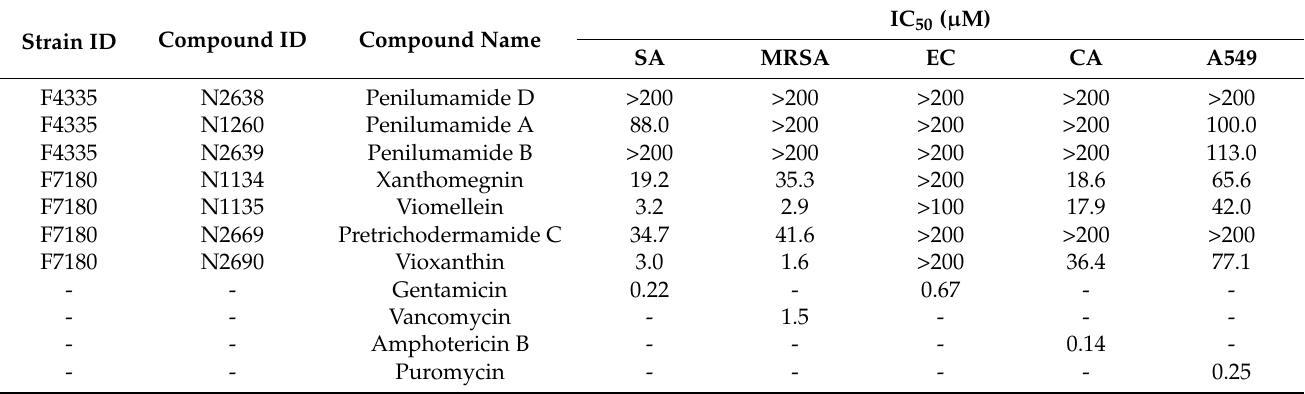
Table 3. Bioactivity of compounds isolated from fungal strains F4335 ( Aspergillus flavipes ) and F7180 ( Penicillium janthinellum ) against SA ( Staphylococcus aureus ATCC 25923), MRSA (Methicillin-resistant Staphylococcus aureus ATCC 33591), EC ( Escherichia coli ATCC 25922), CA ( C. albicans ATCC 10231) and A549 (human lung carcinoma cells ATCC